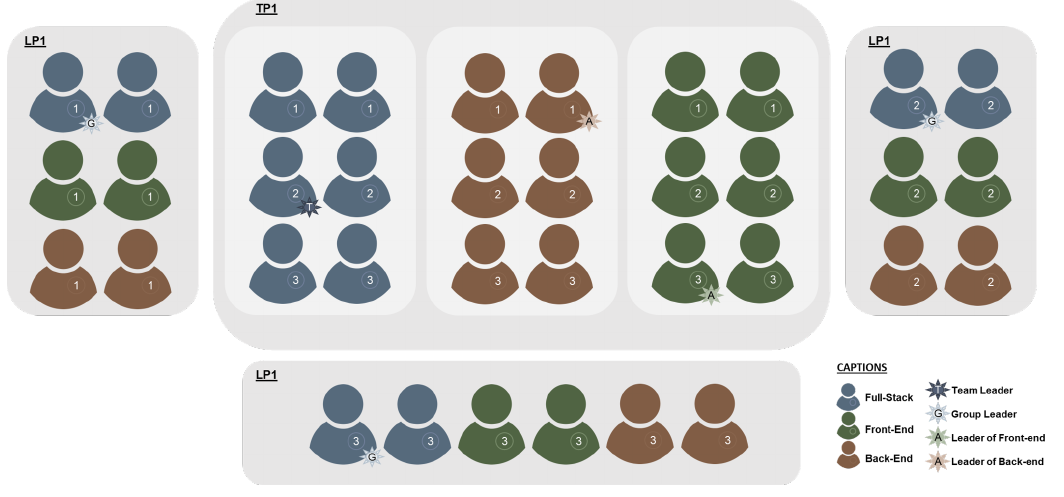
Figure 4. Pratical classes